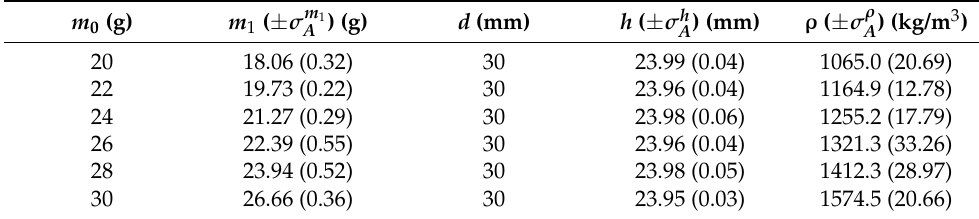
Table 1. Sample density measurement